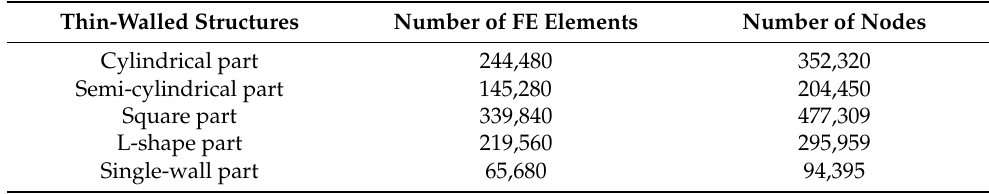
Table 2. Numbers of the FE elements and the nodes for different thin-walled geometries.